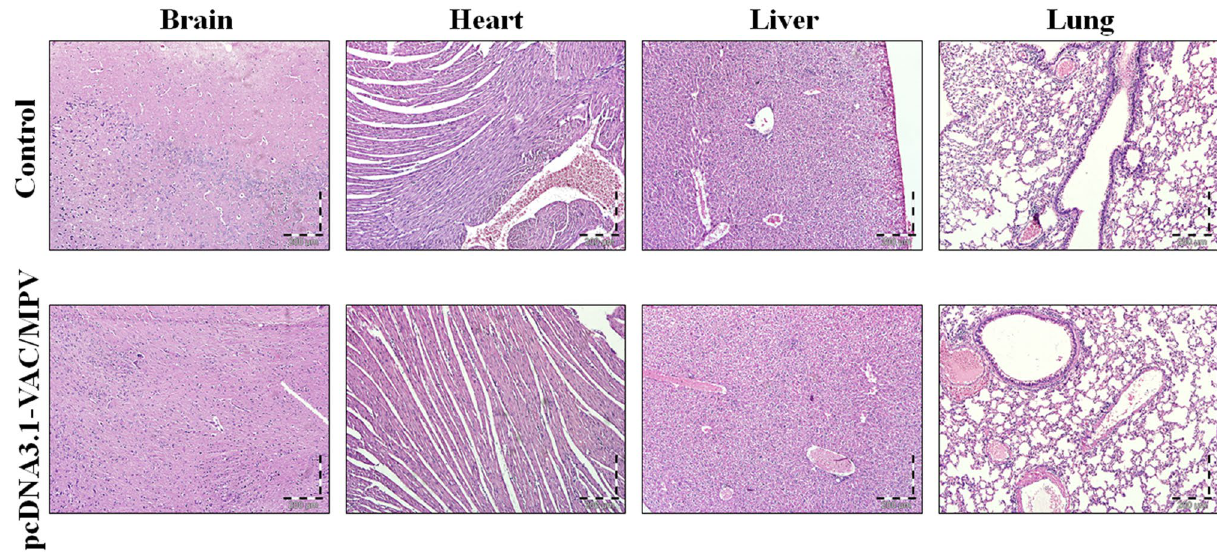
Figure 5. The H&E stained sections of the vital organs (brain, heart, lungs, liver) of the pcDNA3.1-VAC/MPV immunized non-tumor bearing BALB/c mice at the 30th day after the last